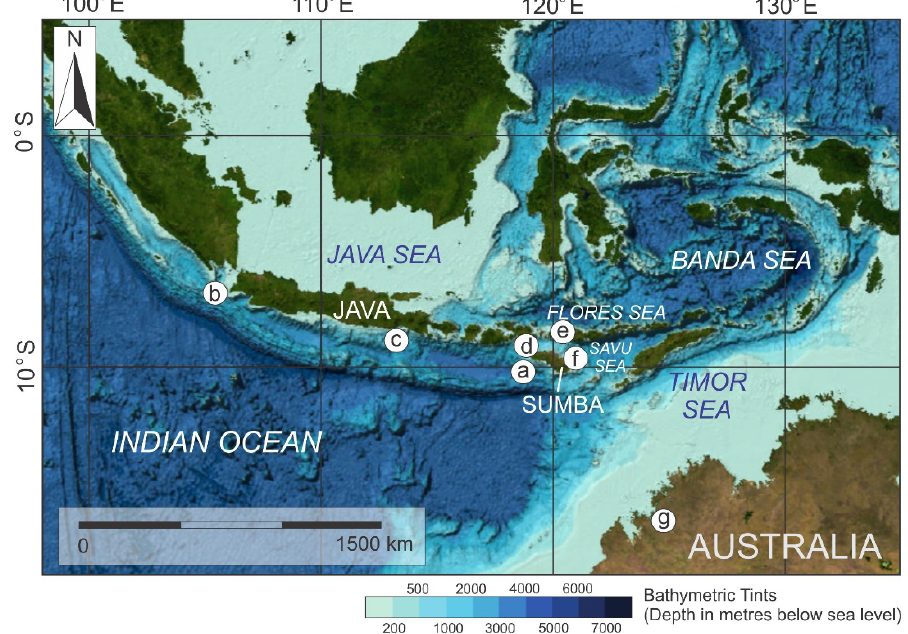
Figure 2. The location of core ST08 (( a ), this study) and other studies used for comparison, i.e., GeoB10043-3 ( b ) [10], GeoB10053-7 ( c ) [1], GeoB10065-7 ( d ) [2], Liang Luar cave (Flores) ( e ) [16], GeoB10069-3 ( f ) [28,72], and Bali Gown cave (northwest Australia) ( g ) [14]. Bathymetric data were obtained from the General Bathymetric Chart of the Oceans (GEBCO) [73].